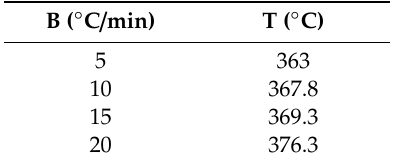
Table 2. Inflection point temperatures at di ff erent rates for